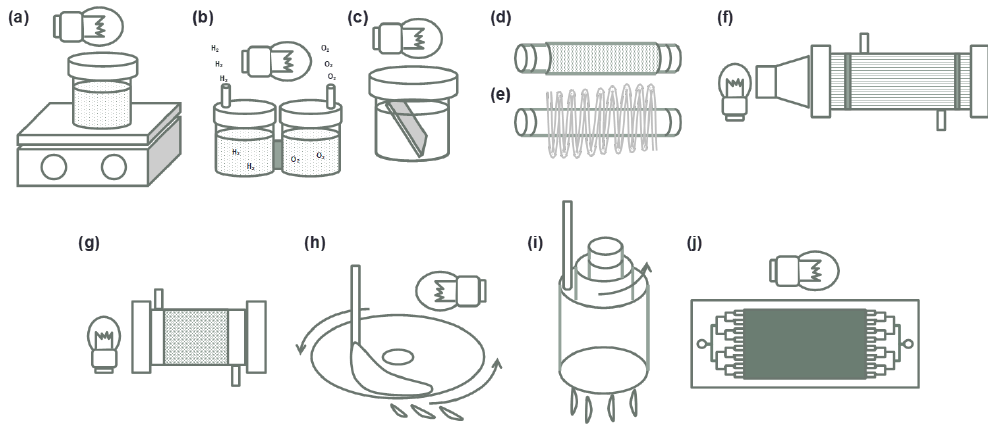
Figure 2. Various photocatalytic reactors: ( a ) slurry-bed reactor, ( b ) twin reactor, ( c ) plate fixed-bed reactor, ( d ) photocatalyst coated on the surface (or material covering the surface) of the light tube, ( e ) tube reactor, ( f ) fiber reactor, ( g ) photocatalyst deposited inside large surface area material or packed bed reactor, ( h ) spinning disk reactor, ( i ) Taylor vortex reactor, and ( j ) micro-optical fluidic chip